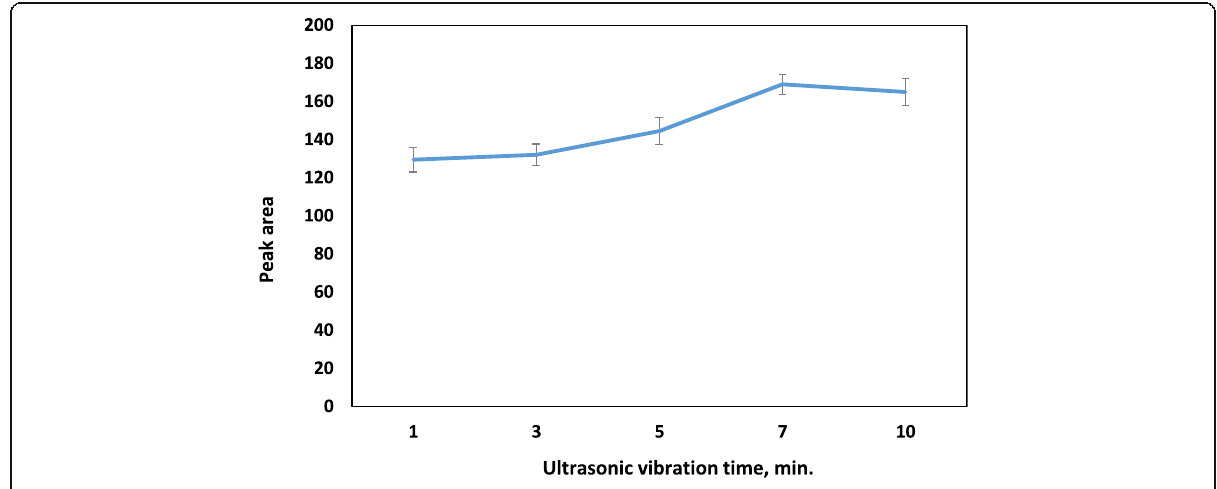
Fig. 6 Effect of ultrasonic vibration time on the extraction efficiency of DKT ( n = 3)